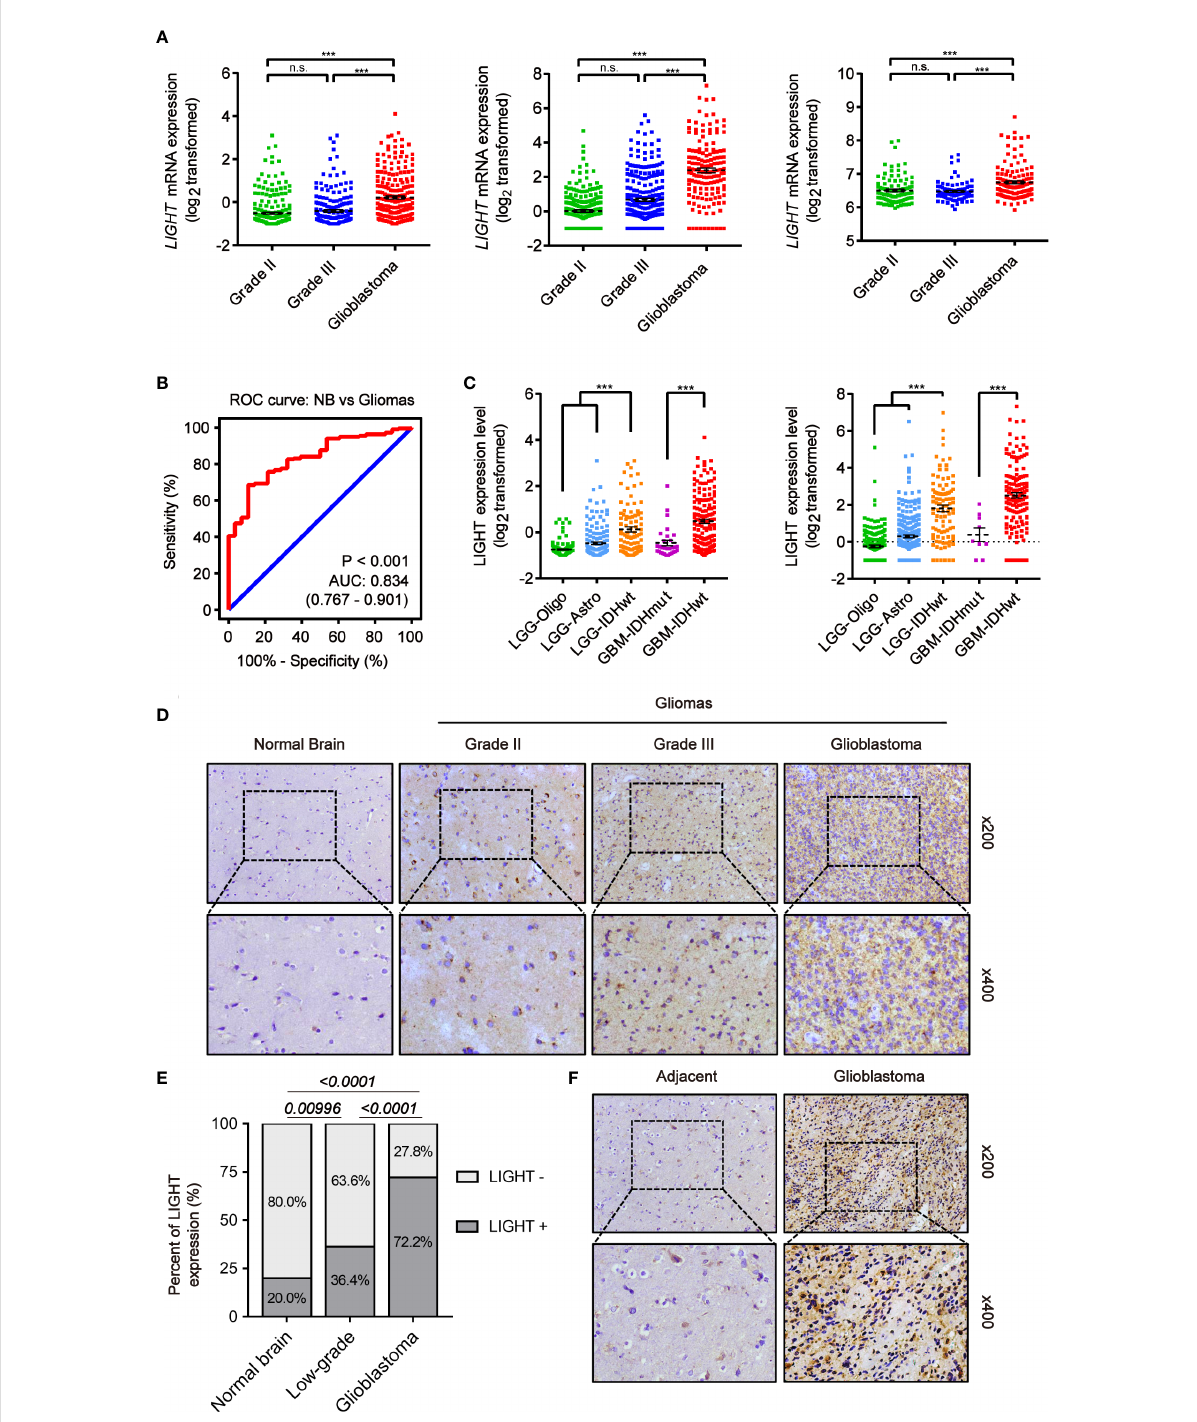
FIGURE 1 Increased LIGHT expression in higher-WHO-grade gliomas. (A) LIGHT levels of WHO categories II – IV mRNA expression in the TCGA (n = 667), CGGA (n = 693), and Rembrandt (n = 510). (B) The speci fi city and sensitivity of LIGHT were analyzed using a Receiver Operating Characteristic (ROC) curve, and it was proposed that LIGHT might be used as a diagnostic marker for gliomas. (C) The 2016 WHO classi fi cation was used to categorize the LIGHT mRNA expression levels in gliomas from the TCGA (n = 667) and CGGA (n = 693) datasets. (D, F) are